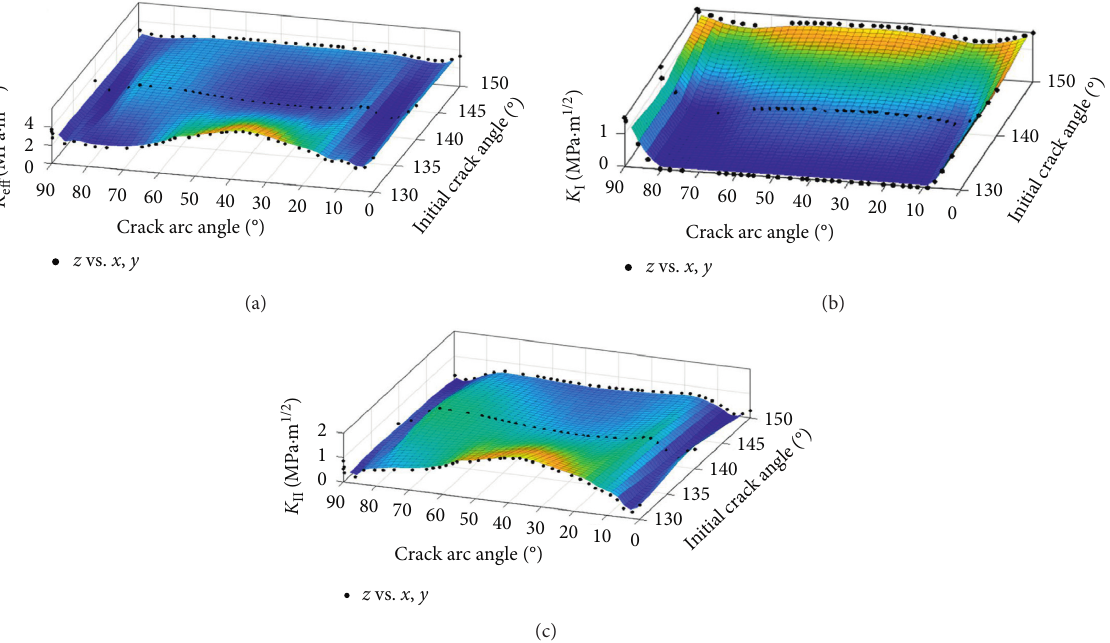
Figure 18: Calculation of the SIFs of crack III: (a) the calculation result of K eff for crack III at different initial crack angles; (b) the calculation result of K I for crack III at different initial crack angles; (c) the calculation result of K II for crack III at different initial crack